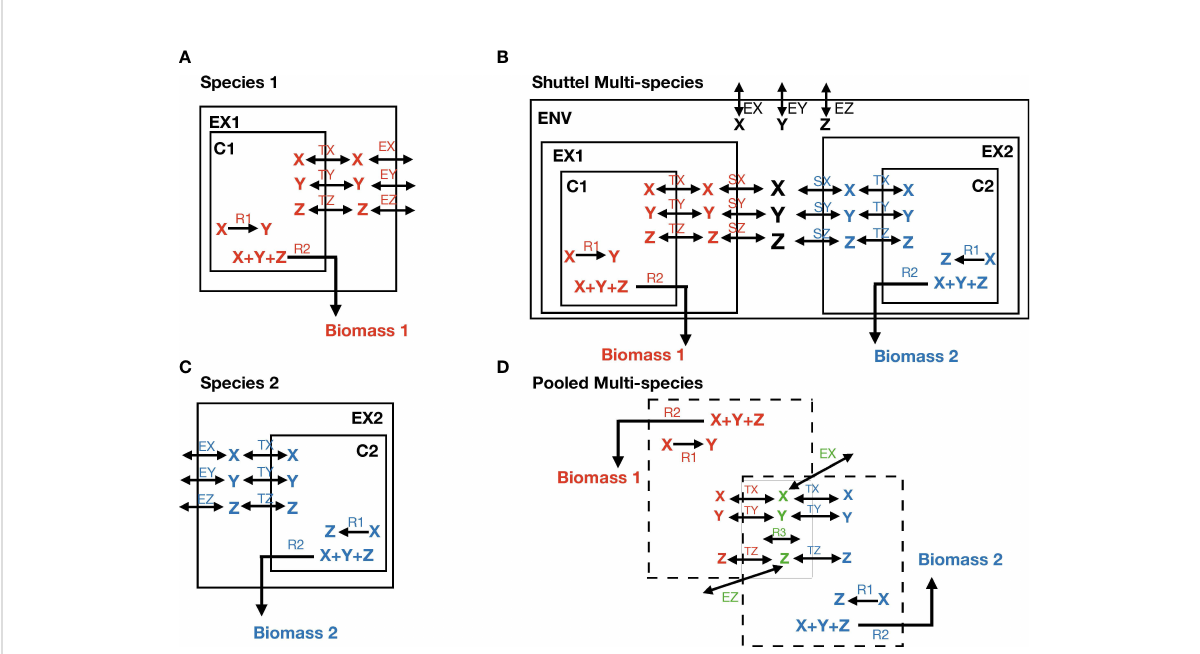
FIGURE 1 The de fi nition of the multi-species model. (A, B) Show the individual model of each species. X, Y, and Z are metabolites; EX, EY, and EZ stand for exchange reactions that are present in both species; TX, TY, and TZ stand for transport reactions; R1 is a species-speci fi c internal reaction; R2 is biomass reaction. C1 and C2 stand for cytosolic space; EX1 and EX2 for extracellular space. (C) Represents the construction of the shuttle multi- species model. SX stands for shuttle reactions and ENV for environmental space. (D) Represents the construction of the pooled multi-species model. The species-speci fi c reactions R1 and R2, and TX, TY, and TZ appear in their own color match with the species, whereas X, Y, Z, EX, EY (not present due to lack of space), and EZ are common reactions and metabolites. They take place only once in the model with different color as green. R3 is also a common internal